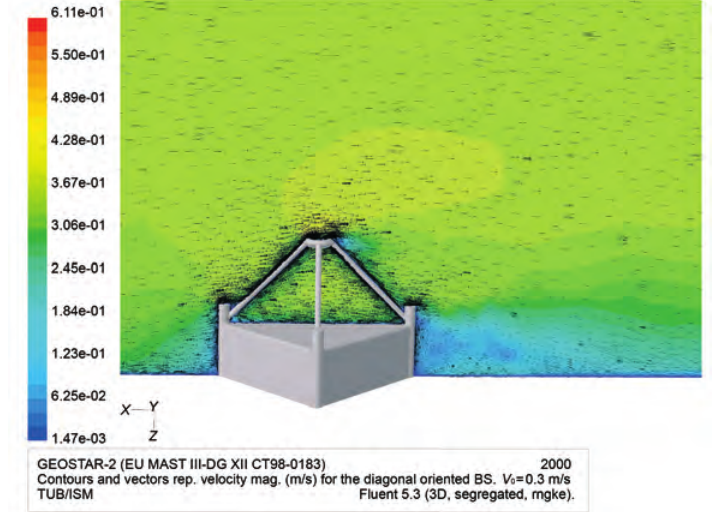
Fig. 4a. 2D current in a plane through the centre of the observatory with a far-field speed of 300 mm/s along a diagonal. Note that current is coming from the